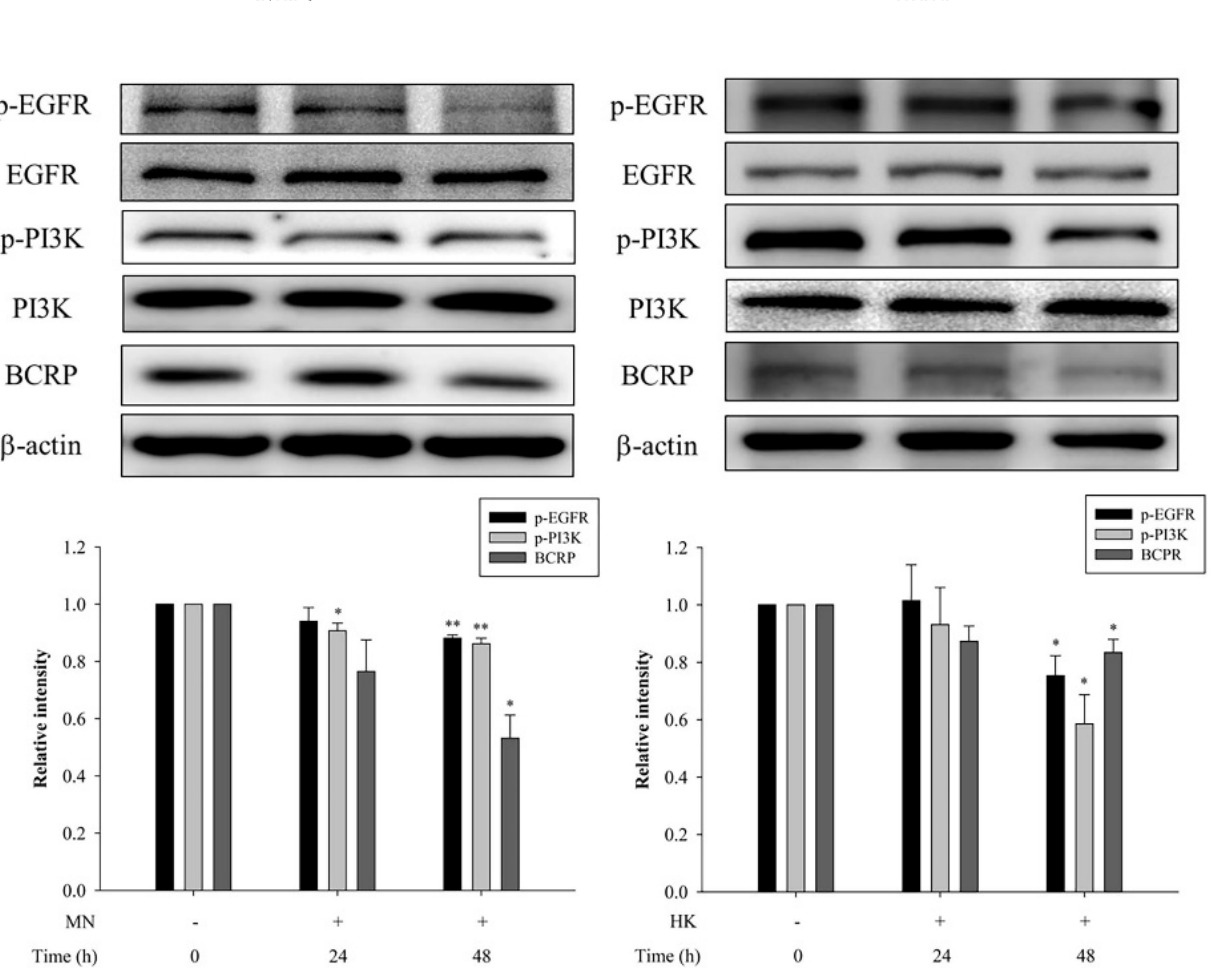
Figure 5. Effects of MN (12.5 µ M) and HK (12.5 µ M) on the protein expressions of p-EGFR, EGFR, p-PI3K, PI3K and BCRP, in MDCKII-BCRP cells at 24 h and 48 h after incubation. * p < 0.05, ** p < 0.01.